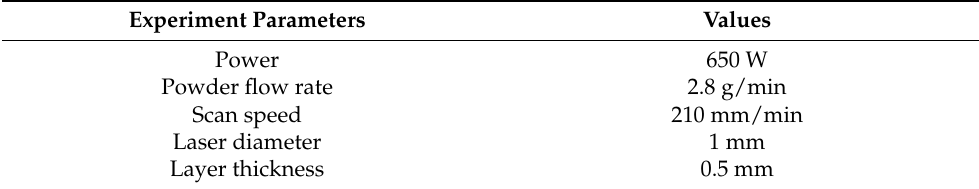
Table 2. Processing parameters for the repair experiment. Experiment Parameters